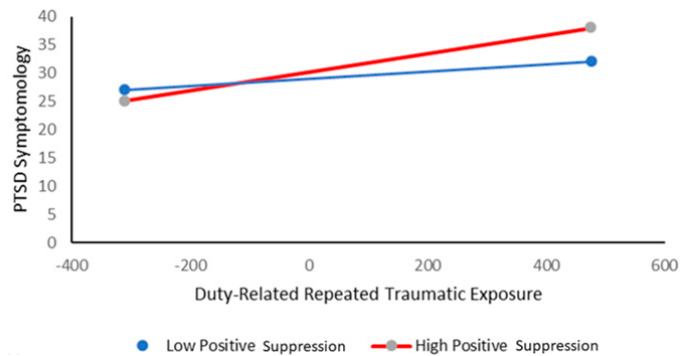
Figure 2. Post-Traumatic Stress Disorder (PTSD) symptomology as a function of duty-related repeated traumatic exposure and positive suppression.